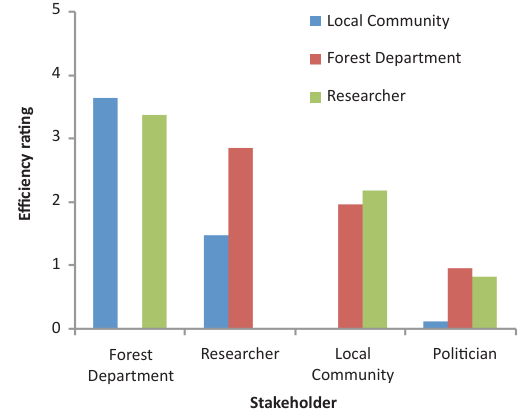
Figure 3. Stakeholder rating of the efficiency of other participating stakeholders involved in biodiversity conservation in the Western